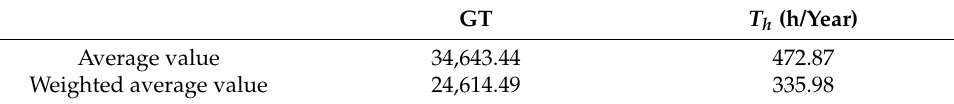
Table 17. Average value and weighted average value of GT and T h of the 16 vessels.